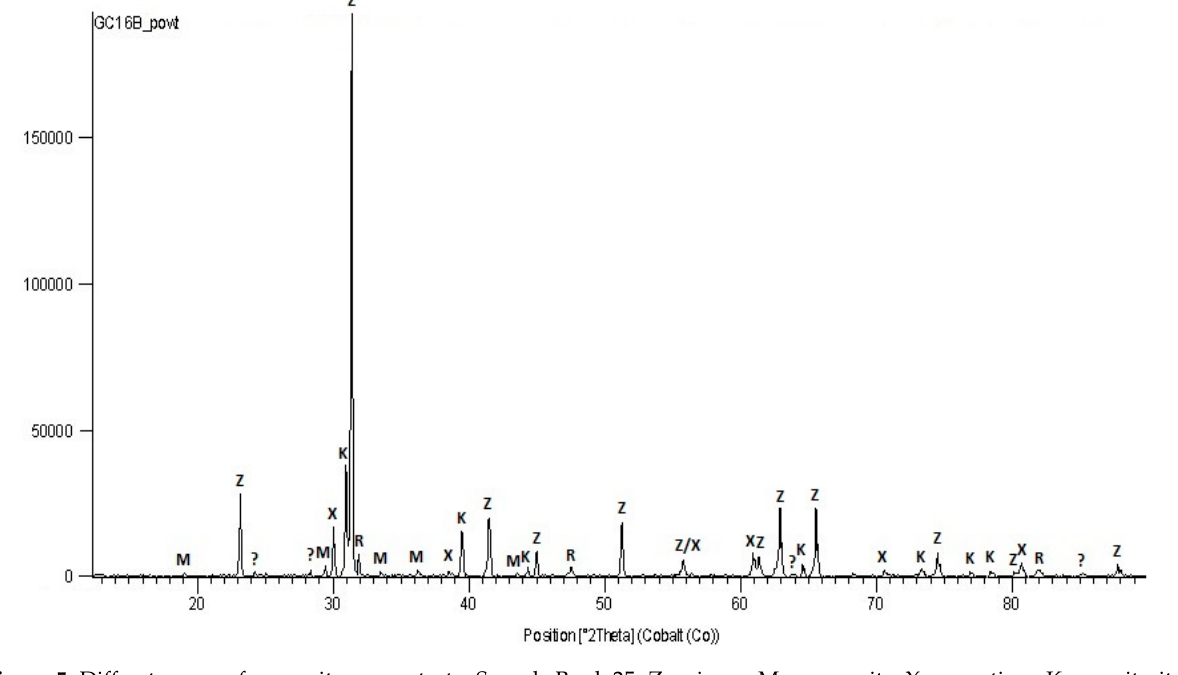
Figure 5. Diffractogram of monazite concentrate. Sample Bngk 25. Z—zircon; M—monazite; X—xenotime; K—cassiterite; R—rutile; ?—unidentified peak, probably Ti-phases.